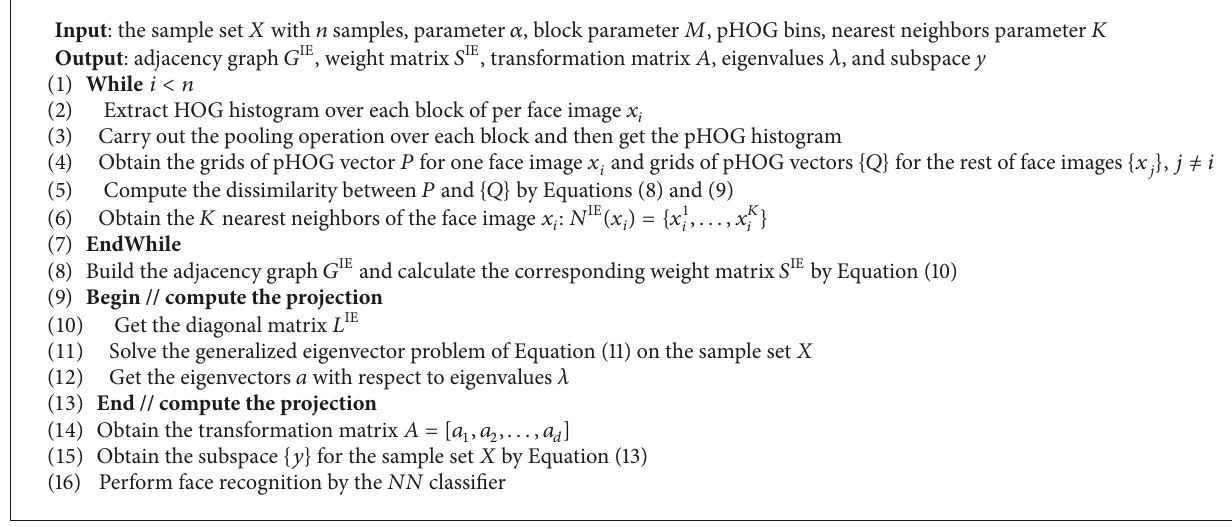
Algorithm 1: The improved EMD metric for LPP.